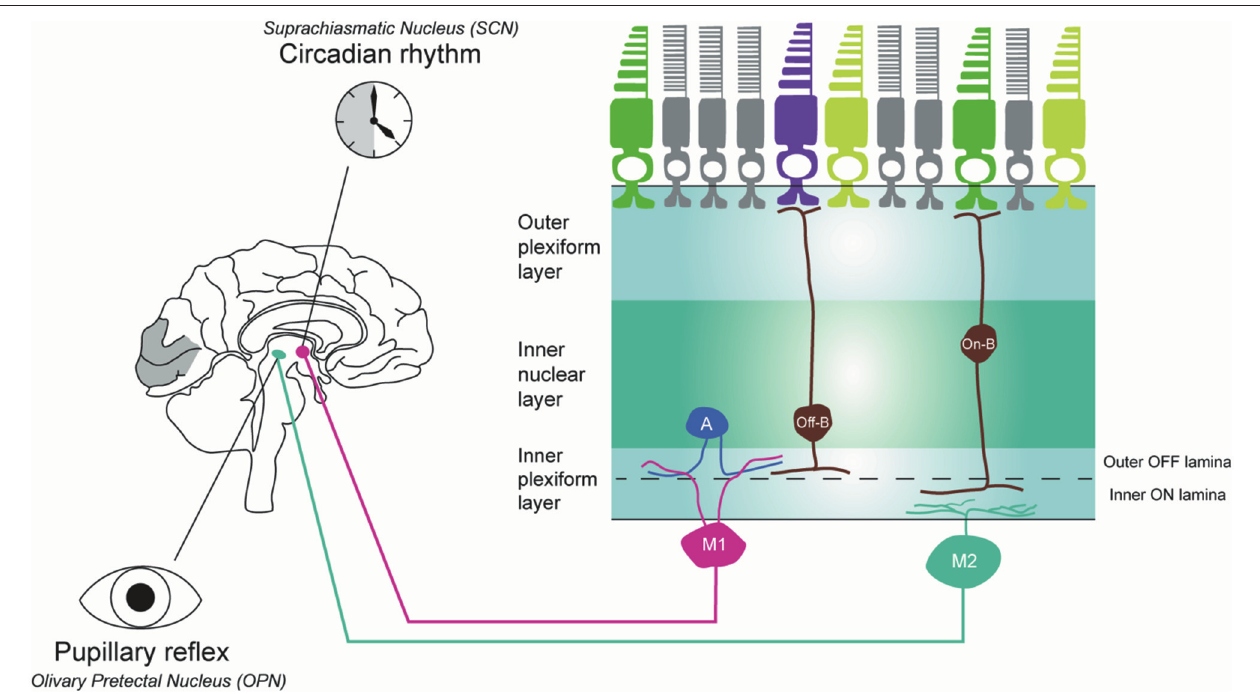
FIGURE 4 | Melanopsin-containing intrinsically photosensitive RGCs in primates. Inner stratifying ipRGCs (M2 ipRGCs) have larger soma and more branched dendrites than outer stratifying ipRGCs. In addition, the dendrites of M1 ipRGCs are mainly located in the outer IPL layer, whereas M2 ipRGCs are in the outer IPL layer close to the ganglion cell layer. M1 ipRGCs project to the suprachiasmatic nucleus (SCN) to synchronize the circadian clock and M2 ipRGCs project to the olivary pretectal nucleus (OPN) in the thalamus to control pupillary response. A, amacrine cell; Off-B, Off-bipolar cell; On-B, On-bipolar cell ( by Ungsoo S. Kim